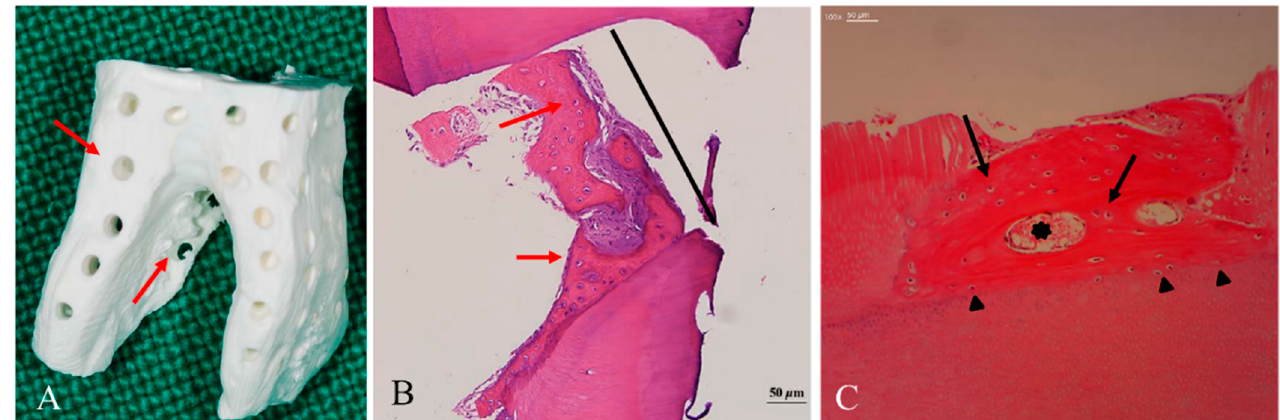
Figure 5. Histological findings of dentin block grafts into the skeletal sites [63]. ( A ) Macropores (300 µm, red arrow) on the dentin block that penetrated from the surface to the pulp space provided the space for vascular invasion. ( B ) At 8 months after the graft, the macropores (300 µm, black line) were filled with newly formed osteoids with embedded active chondrocyte-like cells (red arrow) that closely contacted the inner wall of the macropore. ( C ) At 3 months after the graft, a newly formed osteoid, which had osteocytes (black arrow) and vessels (black asterisk), had been deposited on the dentin block surface. Cellular fusion without fibrous tissue invasion was observed on the border between the osteoid and the dentin matrix (black arrowhead).